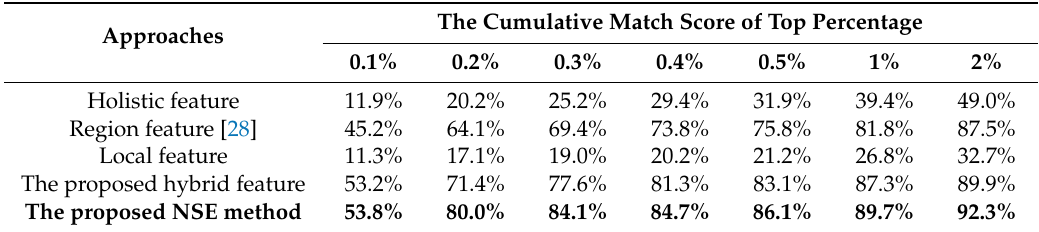
Table 1. Comparison of the performance of our proposed method with the compared methods. The Cumulative Match Score of Top Approaches